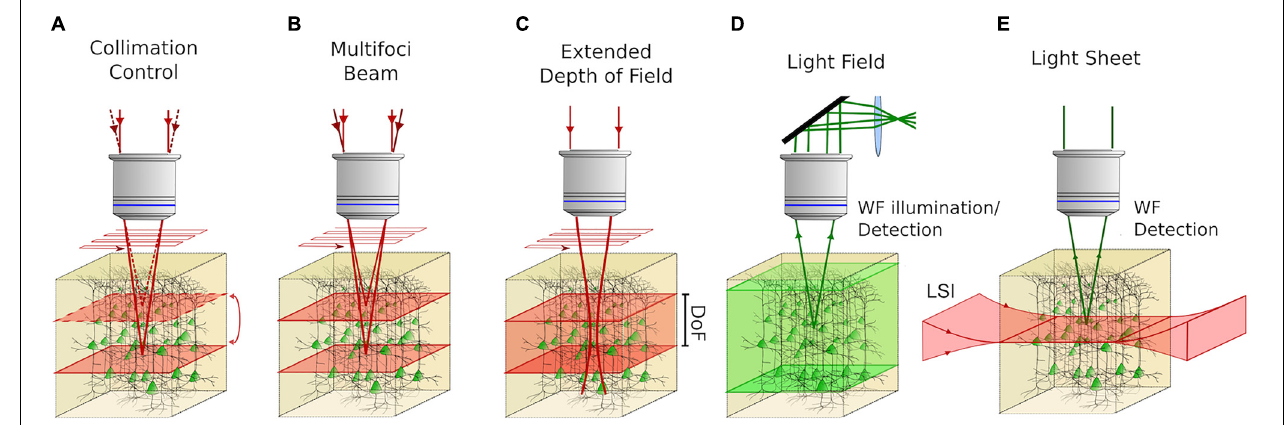
FIGURE 3 | Volume imaging techniques with the possibility to be coupled with 3D photostimulation in all-optical approaches. (A) Control of the collimation of a scanned 2P beam at the back aperture of the objective enables sequentially addressing different focal planes in an extended volume. (B) Multifoci 2P techniques can be used to synchronously scan several planes of the sample providing adequate demixing strategies to distinguish the contribution coming from different planes. (C) Extended Depth of Field (EDF) approaches enable imaging entire volumes by 2D scan of an illumination beam, featuring an extended axial point spread function (Depth of Field; DoF). (D) Light Field Microscopy enables CCD-recorded volume imaging by modulating the fluorescent signal induced in the sample, upon 1P wide-field (WF) illumination by means of a system of microlenses located in the detection path and computational reconstruction algorithms. (E) In Light-Sheet Microscopy 2D scanless imaging is obtained by illuminating the sample with a “sheet” of light in the orthogonal direction of the microscope’s optical axis. In this way, optical sectioning is achieved and 3D volume imaging is performed by scanning the light sheet in the axial direction of the microscope. Red light indicates the excitation beam and green light indicates excited